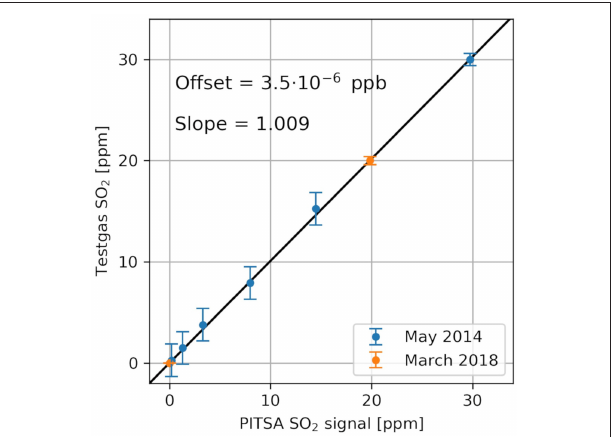
FIGURE 6 | Comparison of the theoretically calculated PITSA response curve with calibration gases of known SO 2 concentrations in N 2 . The black line is an error weighted linear regression. This plot demonstrates the high accuracy of the theoretically calculated PITSA calibration and its long-term stability.